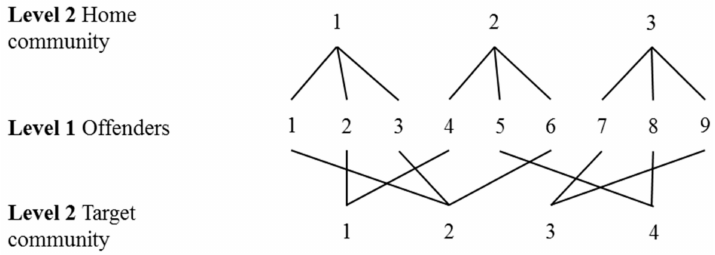
Figure 4. The cross-classified multilevel data